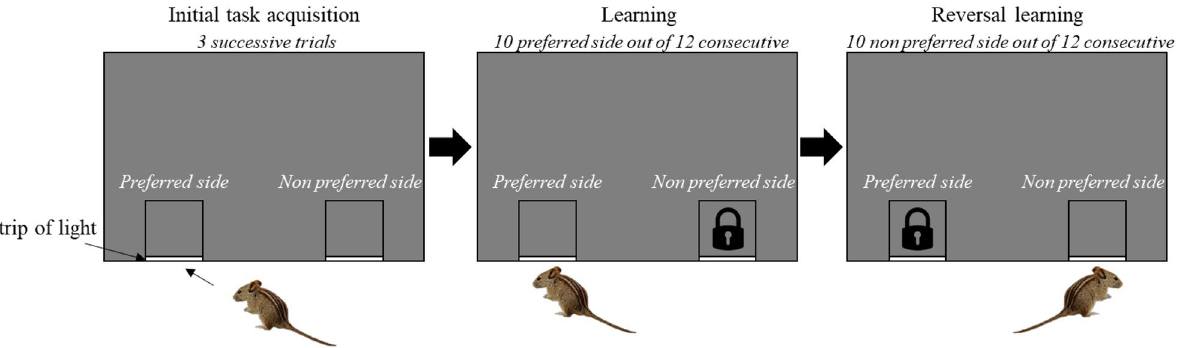
Figure 4. Graphical representation of part of the experimental protocol and device. The mouse has to open one door to escape from the box and return back to its nest. In this example, the mouse chooses the left side (at least 2 left trials out of 3) in the initial task acquisition phase and is then allowed to access the left side (preferred side) during the learning phase whereas the right side door is locked from outside (non-preferred side). After reaching the learning criterion of a total of 10 consecutive correct trials out of 12 during the learning phase, the mouse starts the reversal learning in which it can exit on the right side (non-preferred side) and prevented from exiting the left side (closed door from outside). The mouse had to reach the learning criterion (10 correct responses out of 12 consecutives